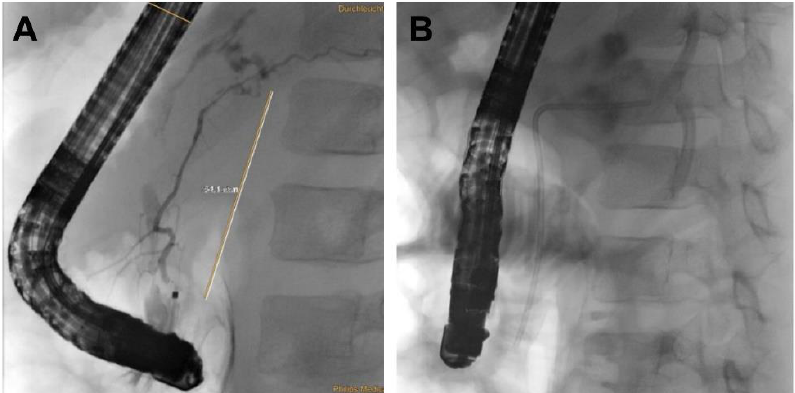
Figure 2. ERCP demonstrating the rupture of the pancreatic duct with paravasation of contrast dye ( A ). Stent placement ( B ).